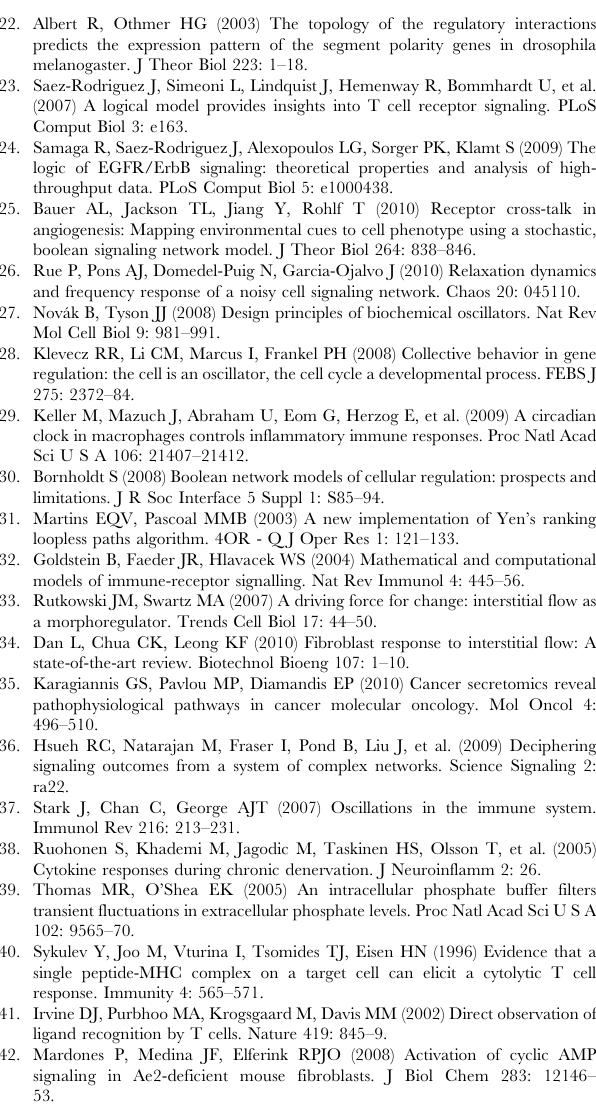
scheme. Figure S12 Role of temporal variation of the chatter. Fraction of responsive cells (realizations) versus chatter level q